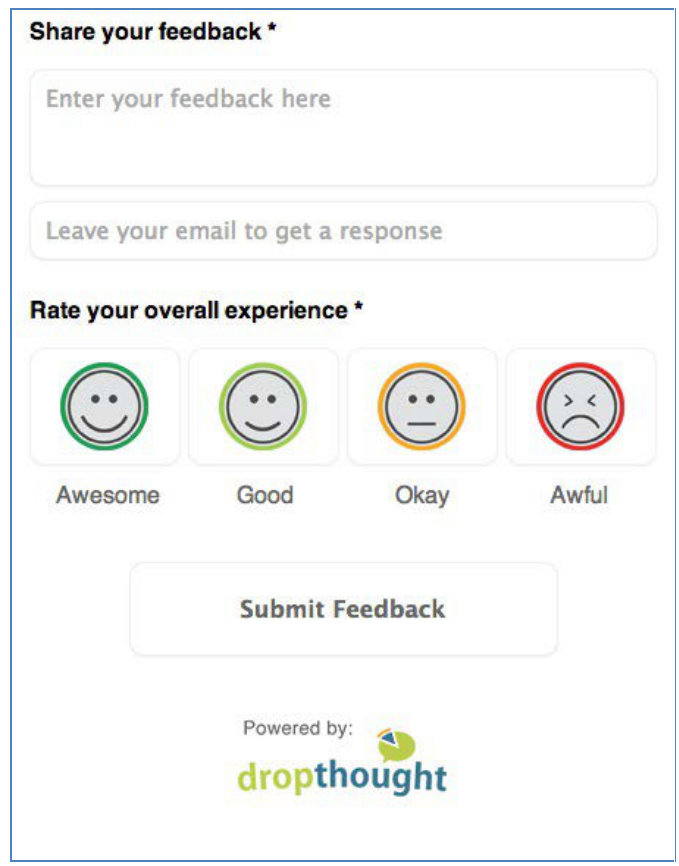
Figure 1 . DropThought